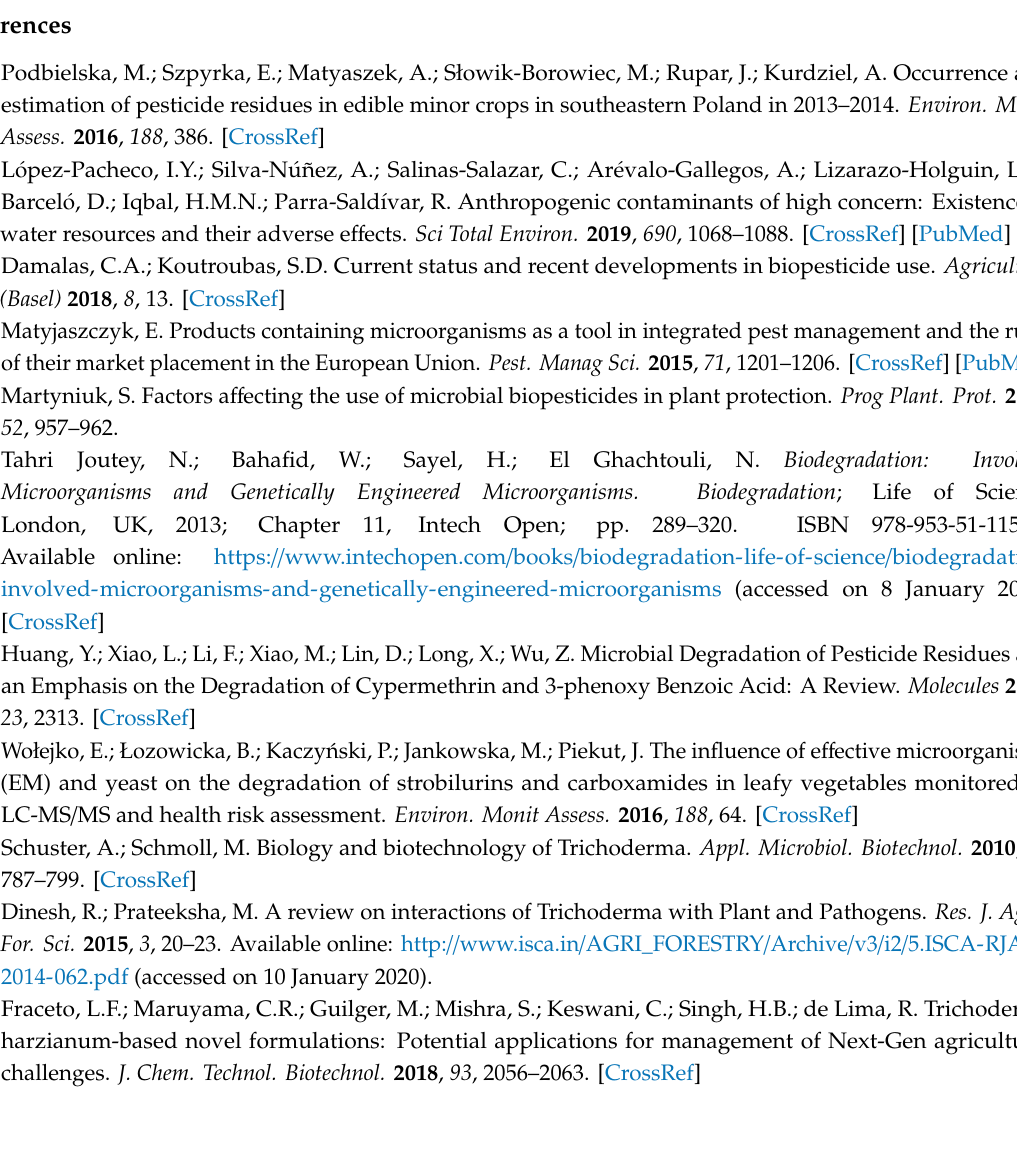
Supplementary Materials: Supplementary materials can be found online. Figure S1. Plots of clomazone dissipations, A—experiment 1, B—experiment 2. Statistically significant p values are shown as p < 0.05 (*) and p < 0.01 (**). Figure S2. Plots of fluazifop-P-butyl dissipations, A—experiment 1, B—experiment 2. Statistically significant p values are shown as p < 0.05 (*) and p < 0.01 (**). Initial values of fluazifop-P-butyl are provided in plots. Figure S3. Plots of metribuzin dissipations, A—experiment 1, B—experiment 2. Statistically significant p value is shown as p < 0.05 (*). Figure S4. Plots of pendimethalin dissipations, A—experiment 1, B—experiment 2. Figure S5. Plots of propyzamide dissipations, A—experiment 1, B—experiment 2. Statistically significant p values are shown as p < 0.05 (*) and p < 0.01